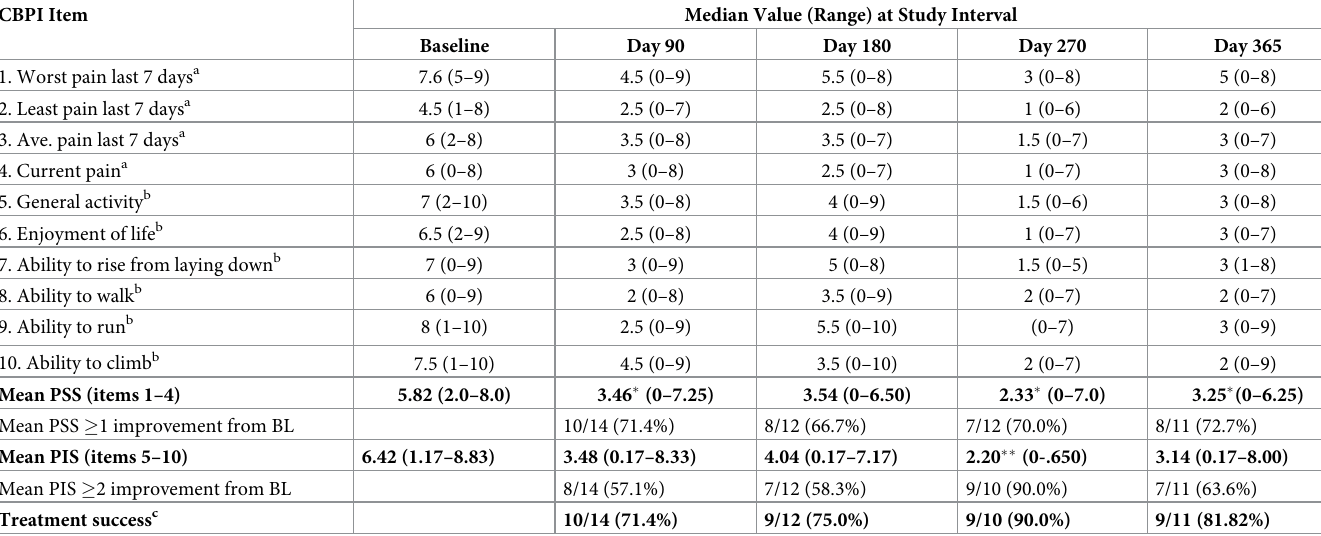
Table 2. Canine Brief Pain Inventory (CBPI) scores in dogs with grade 3 elbow osteoarthritis following per-protocol treatment with 117-tin